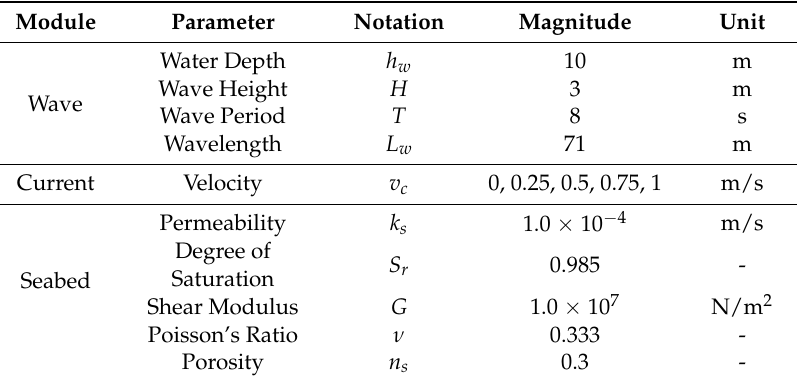
Table 1. Input data of the present